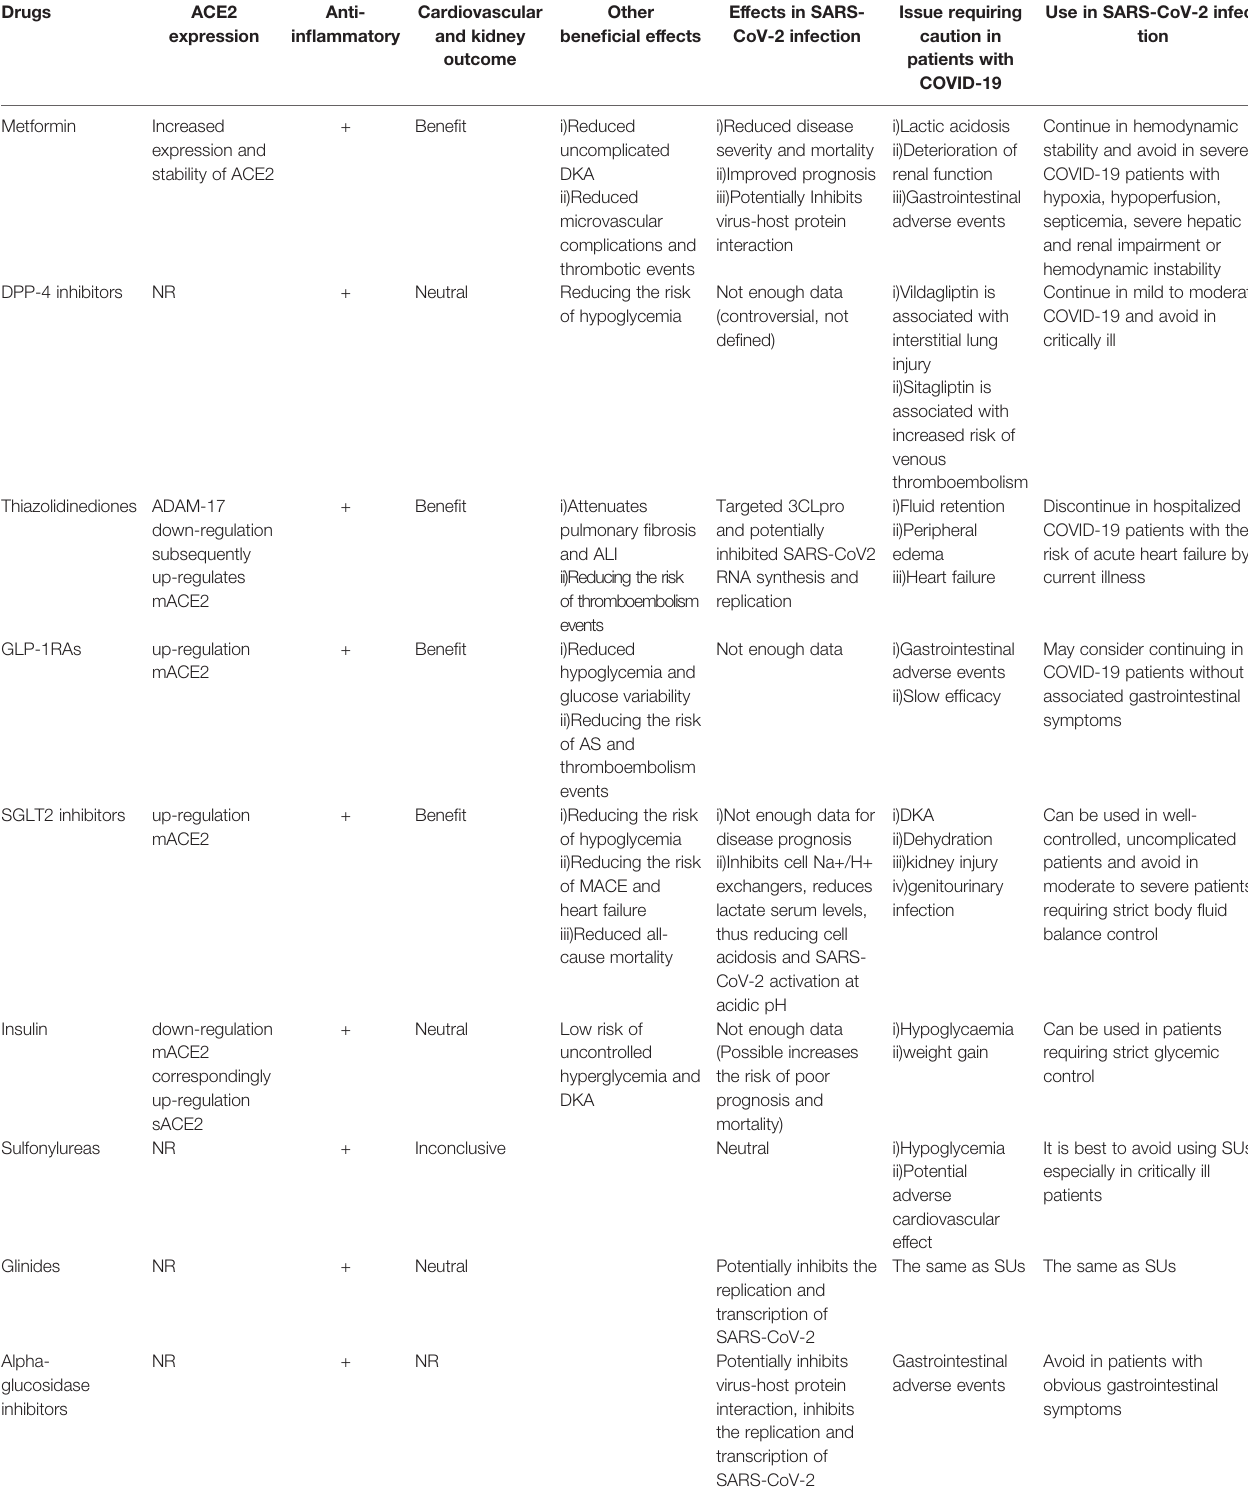
TABLE 1 | A summary of classes of antidiabetic medications and their effects on ACE2 expression, in fl ammation, cardiovascular and kidney outcomes, effects in SARS- CoV-2 infection as well as issues prompting cautious use in patients with